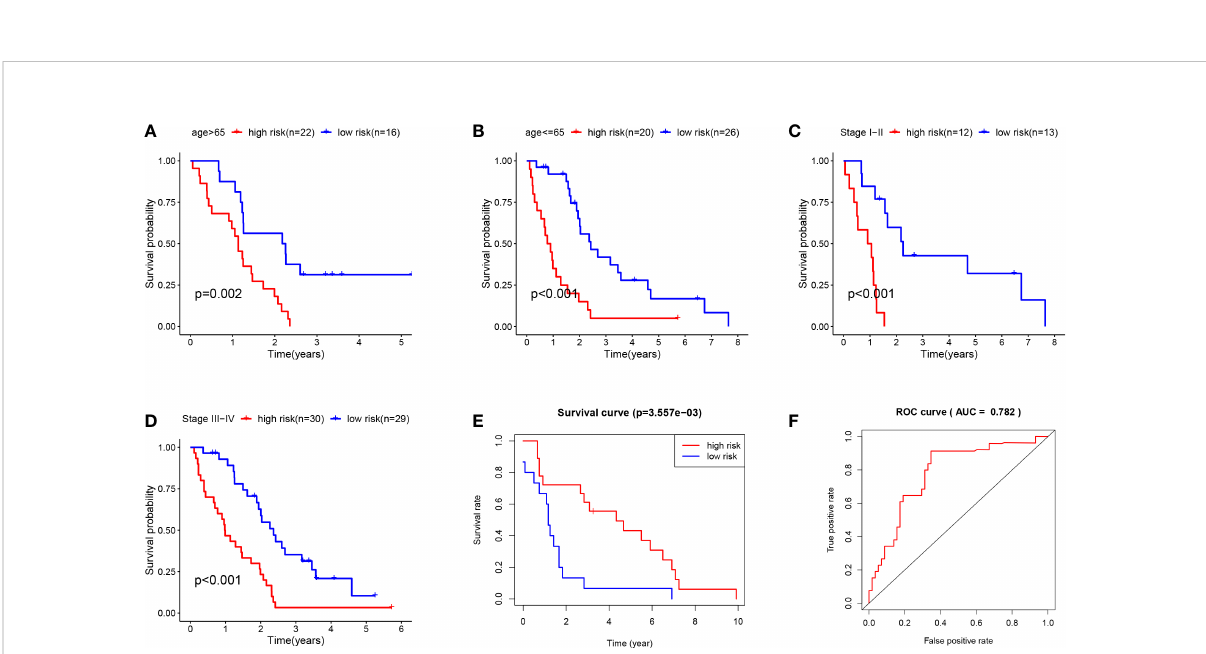
FIGURE 6 (A) K-M curve of TCGA MPM patients younger than 65. (B) KM curve of TCGA MPM patients older than 65. (C) K-M curve of TCGA MPM patients with stage I-II. (D) KM curve of TCGA MPM patients with stage III-IV. (E) K-M curve of GSE67487 patients. (F) ROC curve analysis of GSE67487